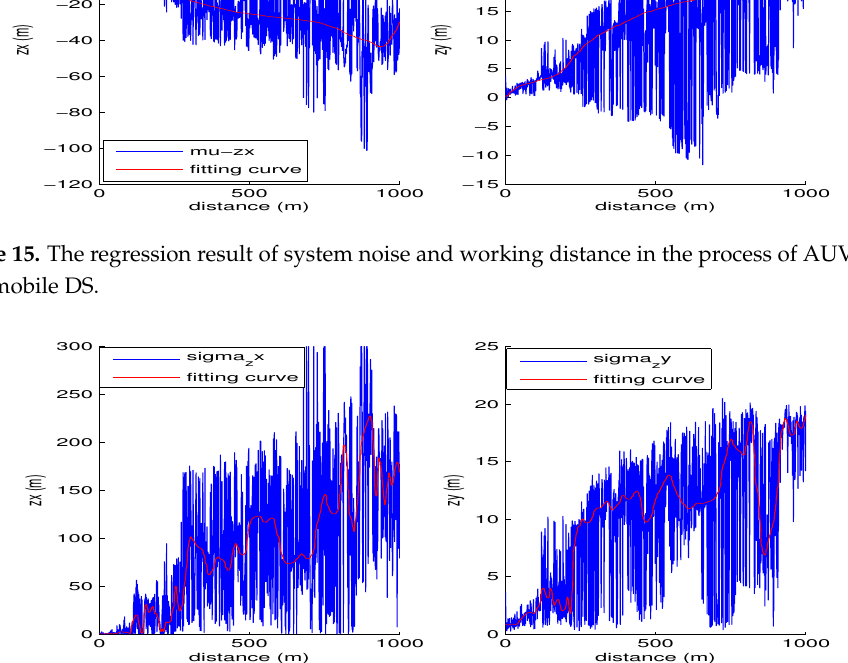
Figure 16. The regression result of the variance of random noise and working distance in the process of AUV docking with mobile